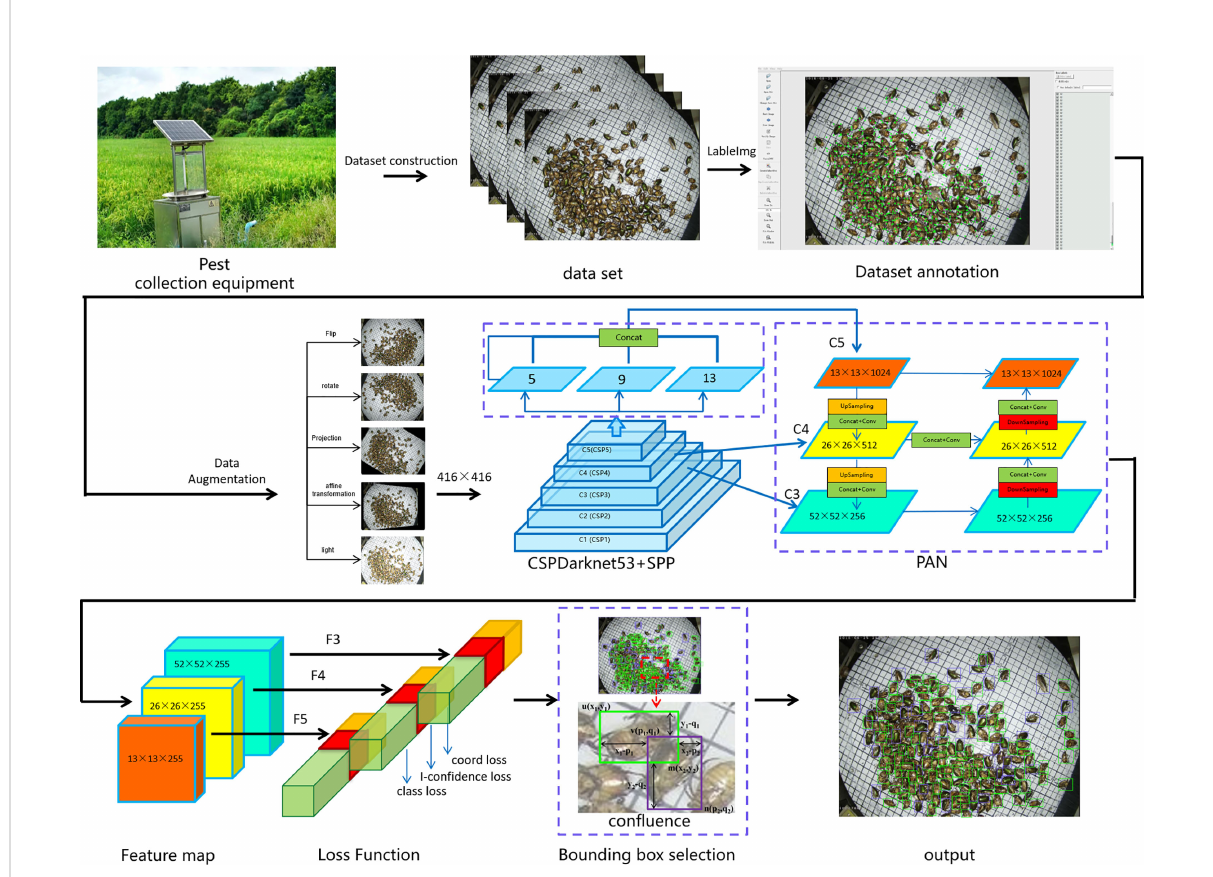
FIGURE 3 Structure diagram of the pest detection and counting framework based on the Pest-YOLO